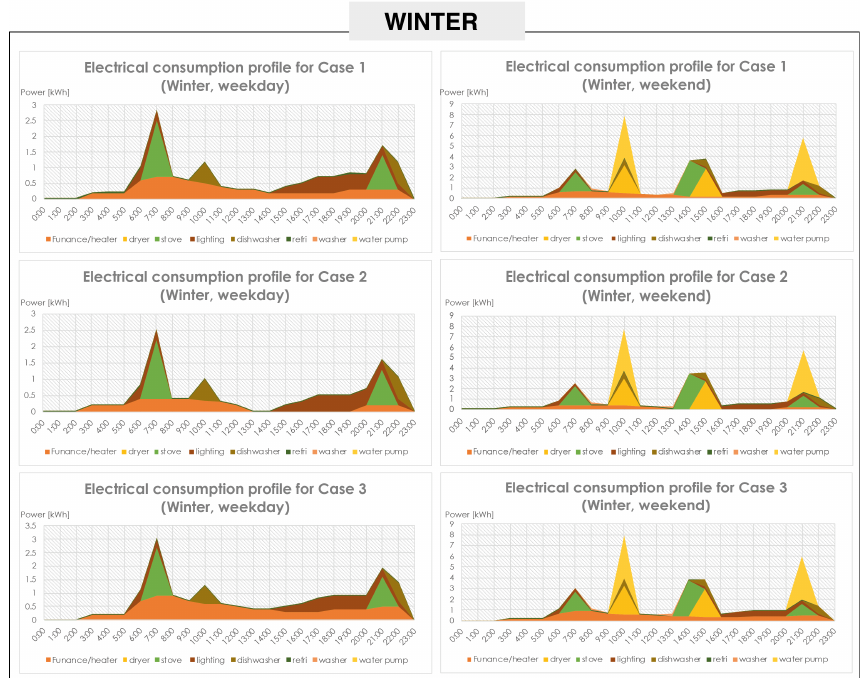
Figure 12. Daily average energy consumption in winter season for Case 1, Case 2, and Case 3 during weekday and